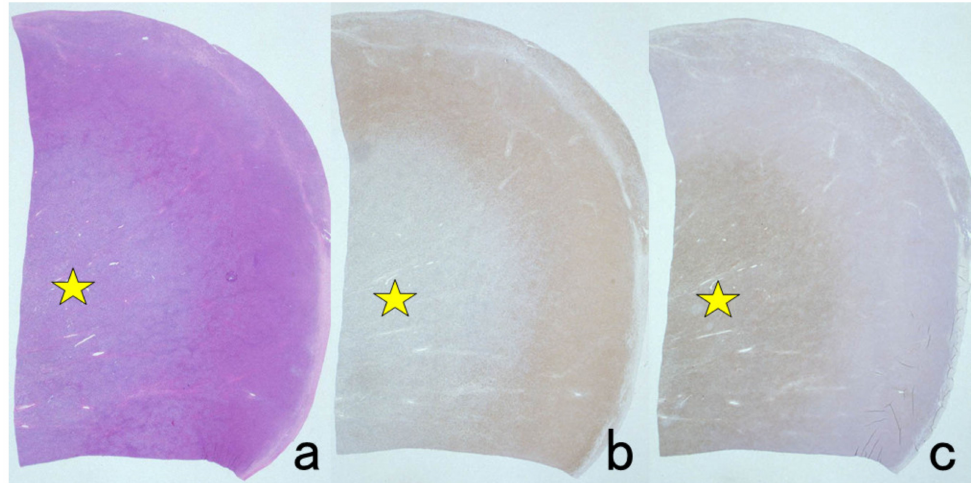
Figure 16. Paradoxical localization of CD45 and vimentin in FFPE malignant lymphoma tissue. ( a ): H&E, ( b ): vimentin and ( c ): CD45 (leukocyte common antigen: LCA). Vimentin is positive in the peripheral zone but negative in the poorly fixed central area (stars). A reversed pattern is recognizable for CD45 localization. The over-fixed outer zone is negative for